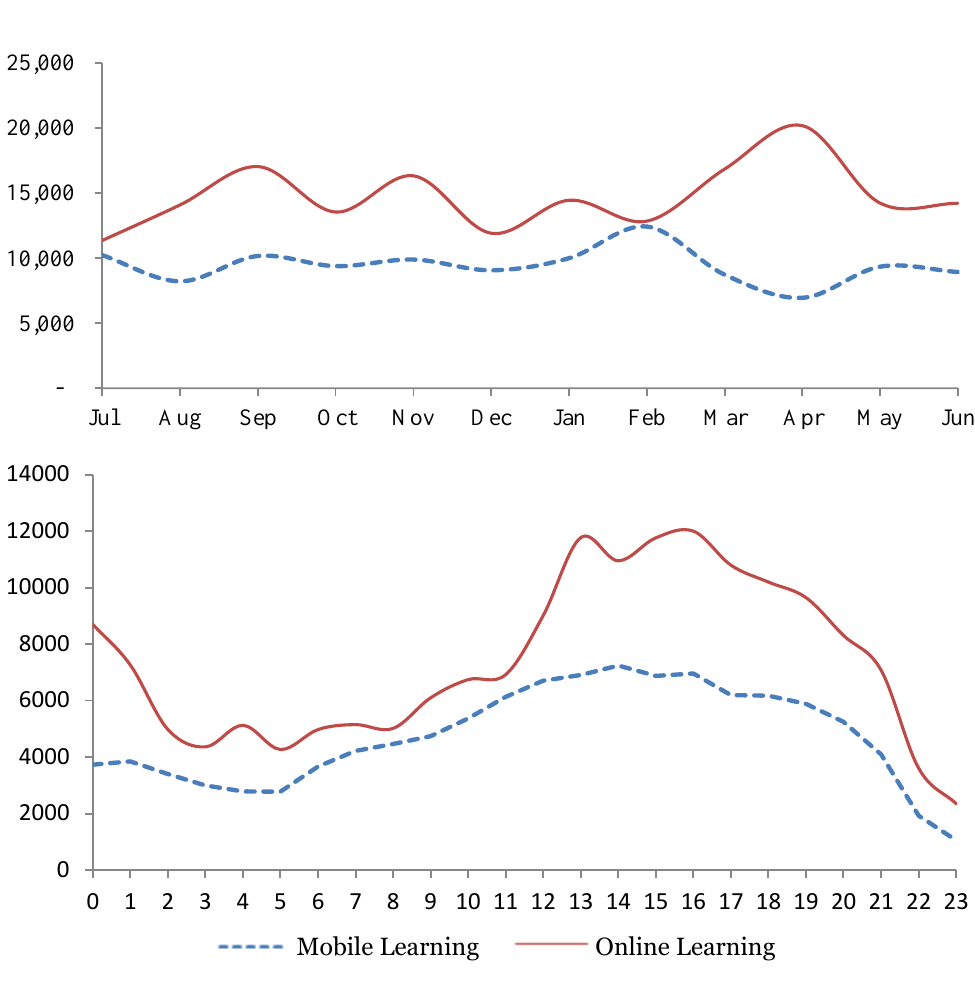
Figure 1. Monthly and hourly line charts of the